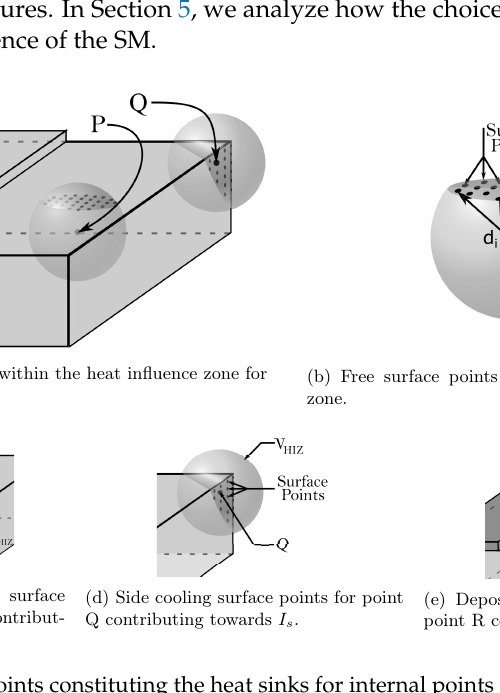
Figure 2: Surface points constituting the heat sinks for internal points P Q, and R. The spheres with radius L HIZ denote the HIZ around the points. The surface points are denoted by black circles.